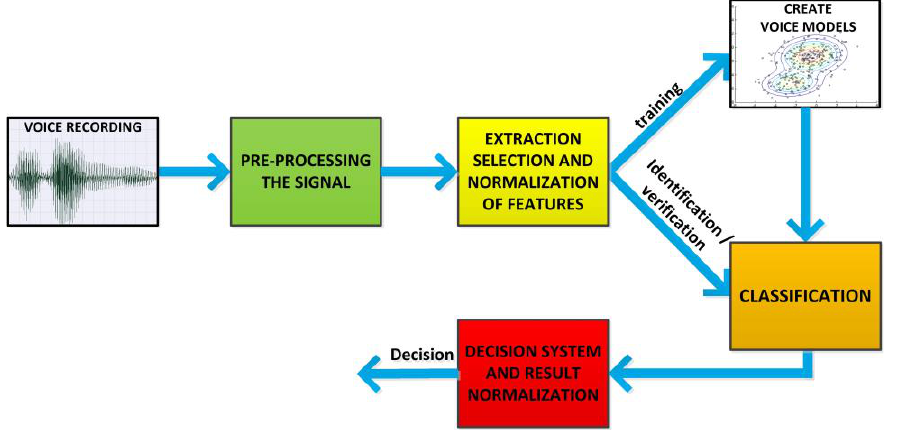
Figure 2. ASR System structure.